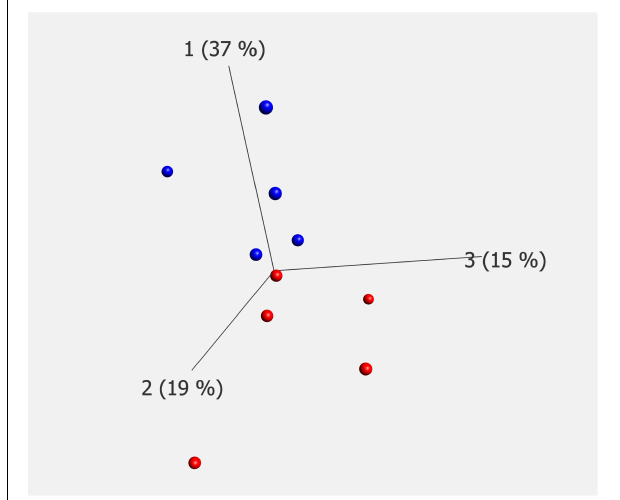
FIGURE 2 | PCA plot of mass spectrometry data. Proteomic analysis of LCM material showed significant differences in protein constitution between AD (red) and controls (blue). Endpoint shows the percentage of variance. The analysis was performed on proteins containing two or more corresponding data points for each of AD and controls, p = 0.0023. PCA, principal component analysis; LCM, laser capture microdissection; AD, Alzheimer’s